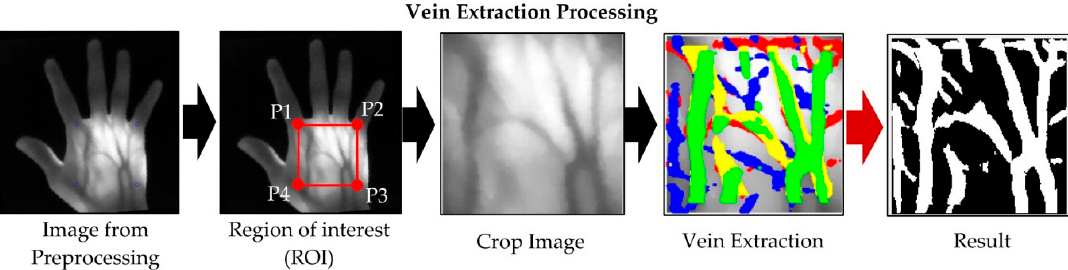
Figure 7. Vein extraction process, including (i) region of interest (ROI) extraction and (ii) vein extraction.